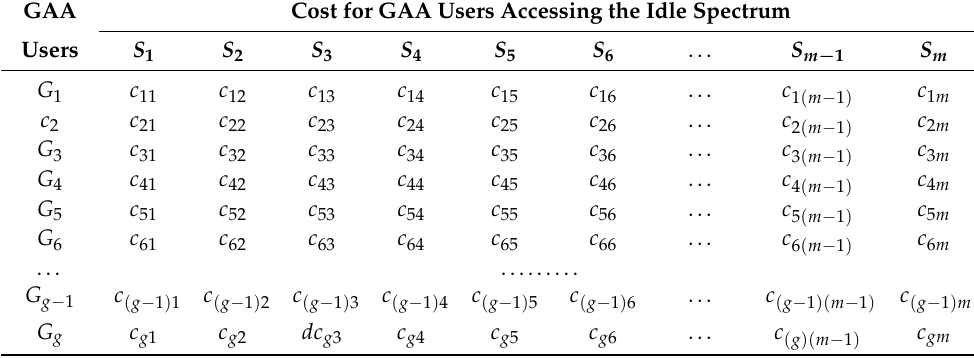
Table 4. Cost for GAA users accessing the idle